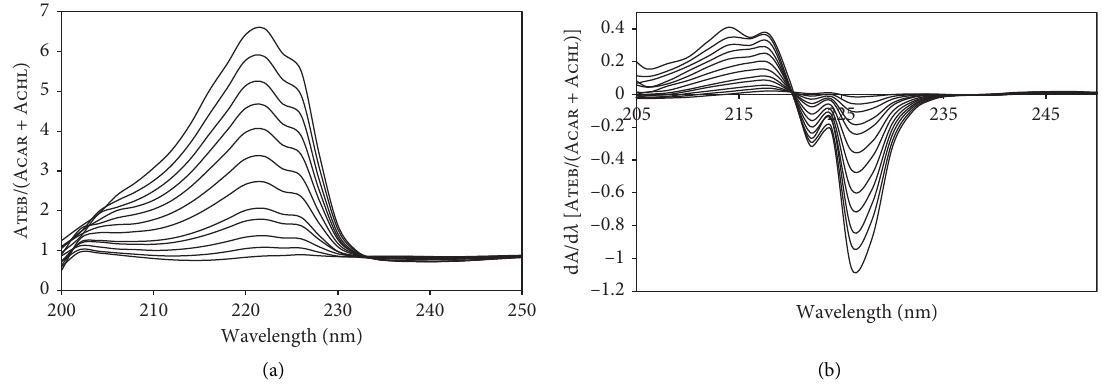
Figure 8: (a) Ratio spectra and (b) first derivative of the ratio spectra of TEB (1, 3, 5, 8, 10, 15, 20, 25, 30, 35, 40, and 45 μ g/mL) using 5 μ g/mL CAR +5 μ g/mL CHL as a double divisor in methanol at Δ λ �